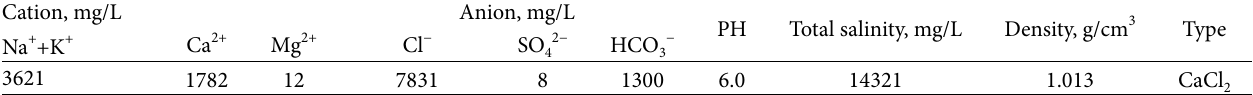
Table 1: The basic properties of formation